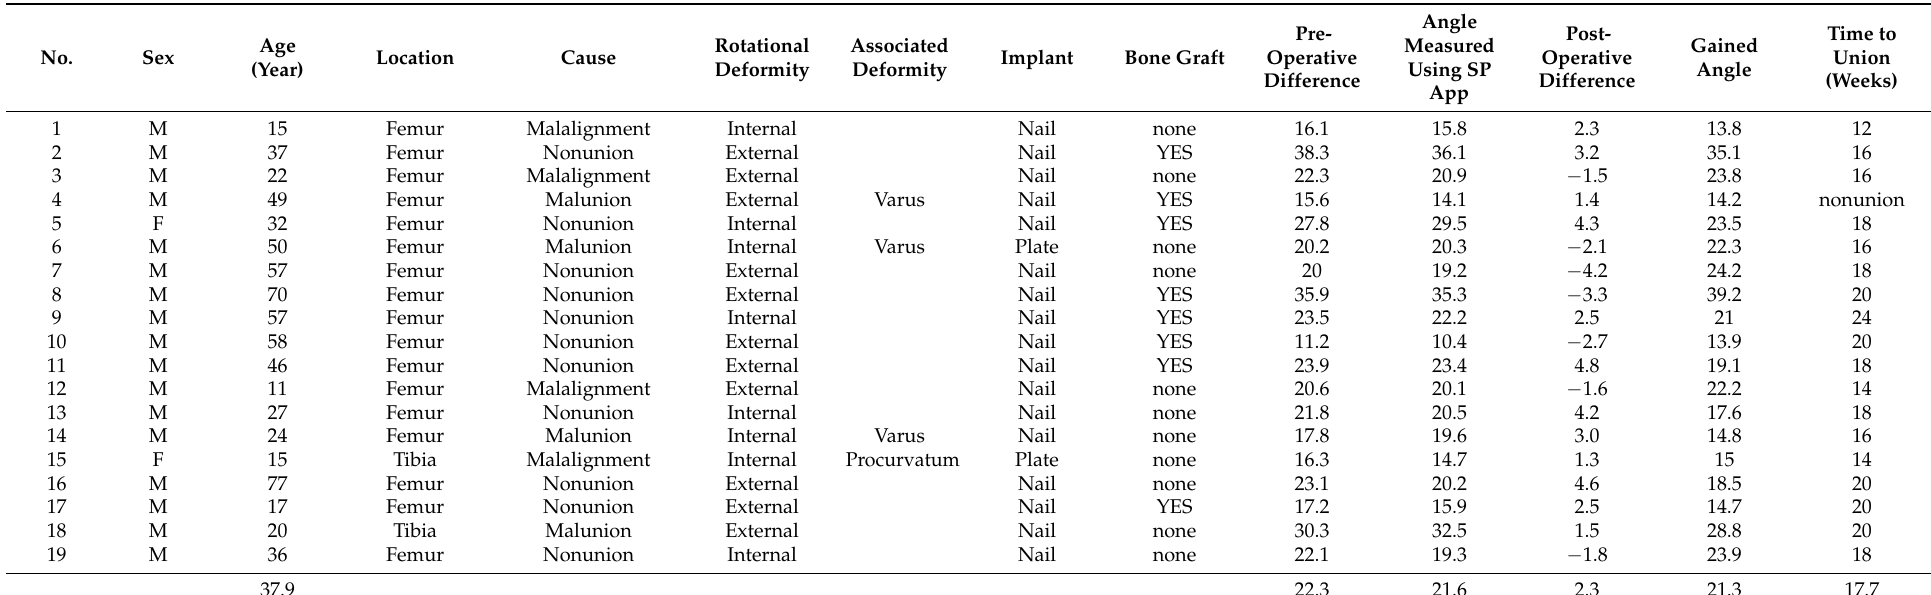
Table 1. Patient demographics and